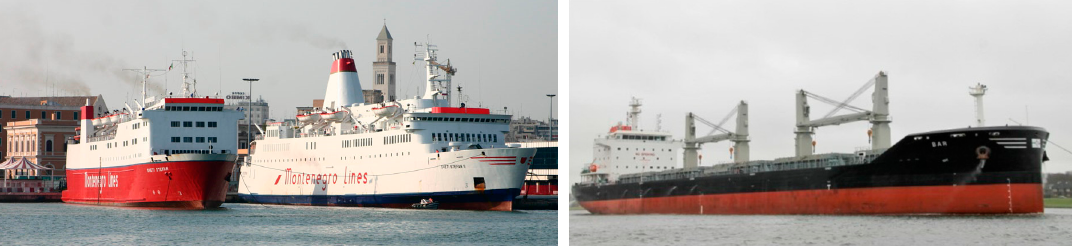
Figure 2. Montenegro Lines passenger ships and cargos at anchor in the Port of Bar, namely, “Sveti Stefan”, “Sveti Stefan II” and “Bar”cargo (from left to right).